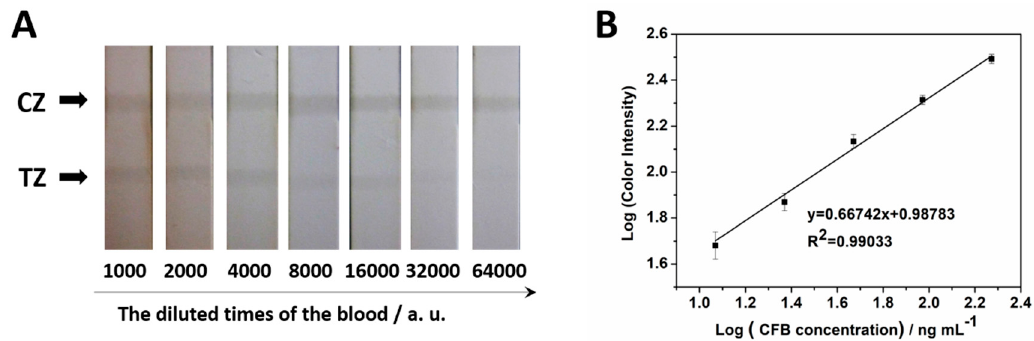
Figure 5. ( A ) Typical photo images for the LFI with blood serial dilutions (1000 to 64,000 times); ( B ) calibration curve. Each data point represents the average value from three different measurements.